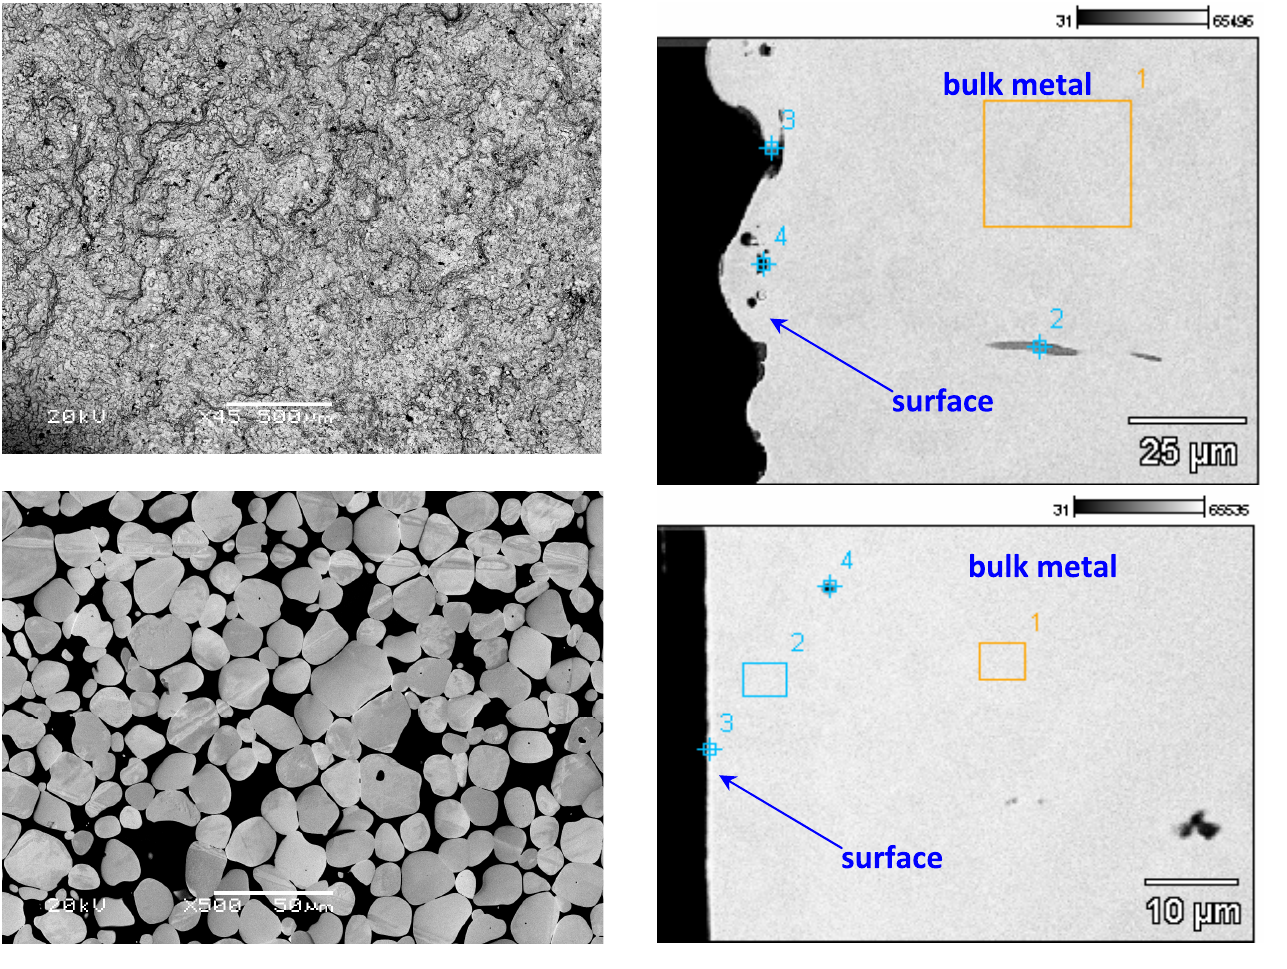
FIG. 7. Backscattered electron micrograph for CW70E. The top picture is a surface picture of an arc region. The bottom picture is a cross section of the bulk material.